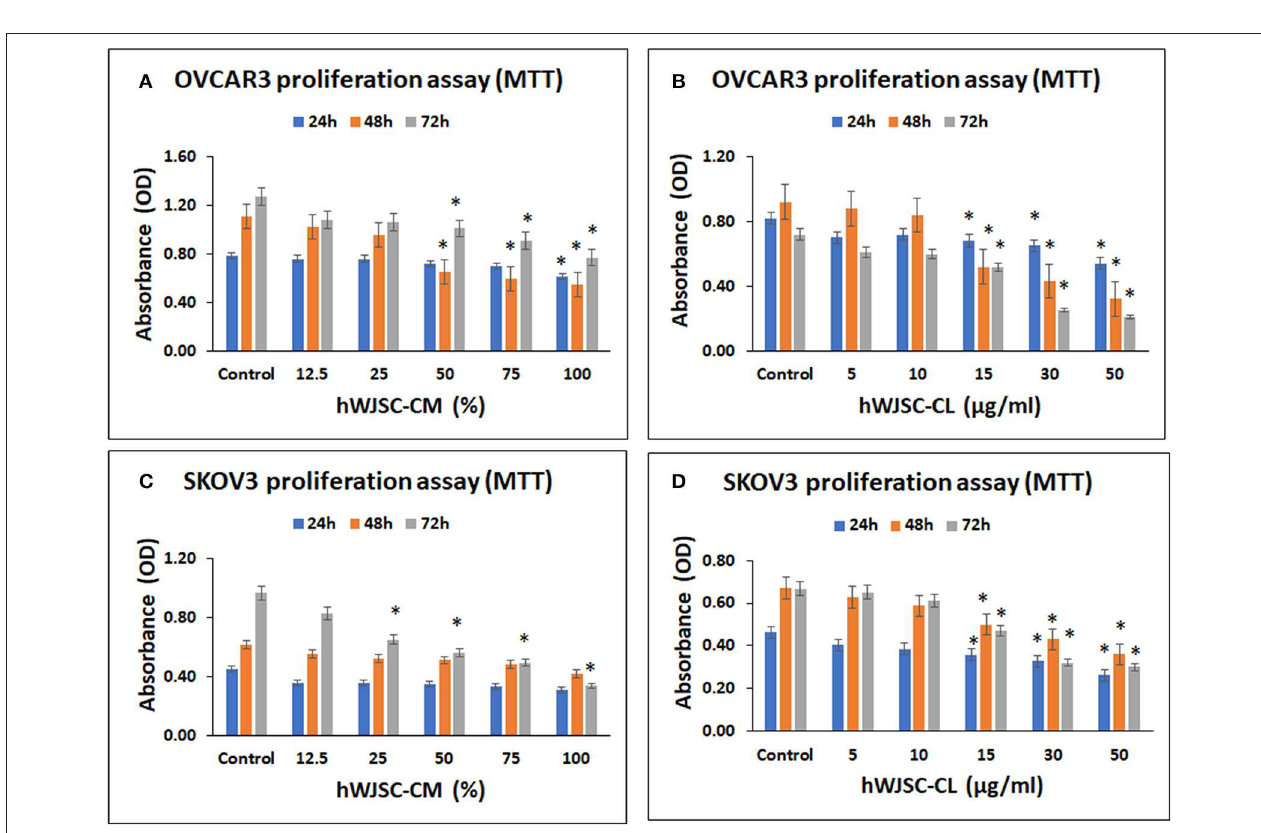
FIGURE 2 | Cell metabolic activity assay of OVCAR3 cells treated with hWJSC-CM (A) ; OVCAR3 cells treated with hWJSC-CL (B) ; SKOV3 cells treated with hWJSC-CM (C) ; and SKOV3 cells treated with hWJSC-CL (D) . The hWJSC-CM and hWJSC-CL inhibited both OVCAR3 and SKOV3 cells more at higher concentrations and duration. The values are expressed as mean ± SEM of three different experiments. *indicates statistical significance ( p < 0.05) compared to the control. hWJSC-CM, human Wharton’s jelly stem cells conditioned medium; hWJSC-CL, human Wharton’s jelly stem cell lysate.